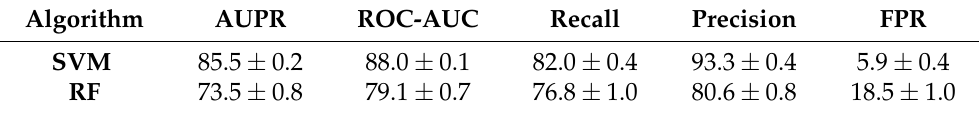
Table 1. Performance of the SVM and RF algorithms for DTI predictions on the RN-datasets.